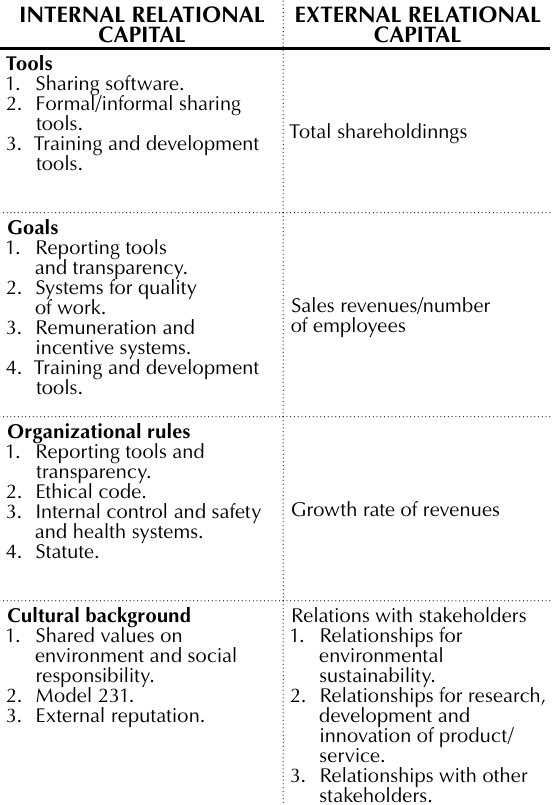
Table 2. Variables of the internal and